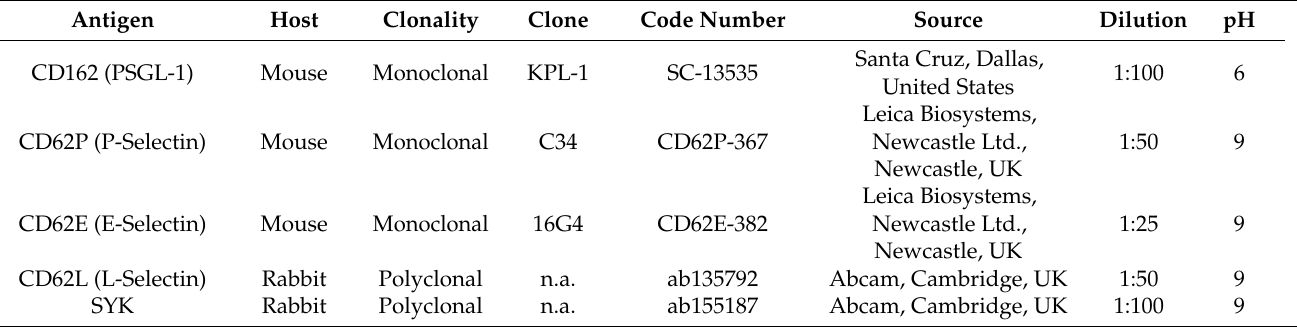
Abbreviations: n.a. = not